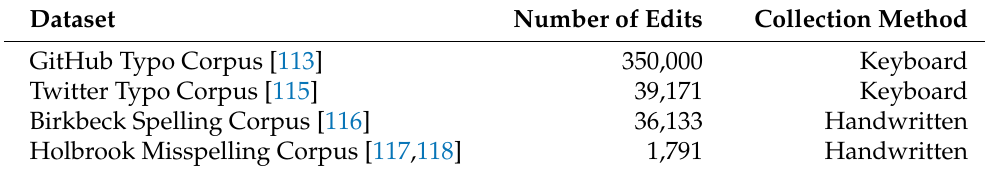
Table 2. Related datasets for English misspelling corrections. Dataset Number of Edits Collection Method GitHub Typo Corpus [113] 350,000 Keyboard Twitter Typo Corpus [115] 39,171 Keyboard Birkbeck Spelling Corpus [116] 36,133 Handwritten Holbrook Misspelling Corpus [117,118] 1,791